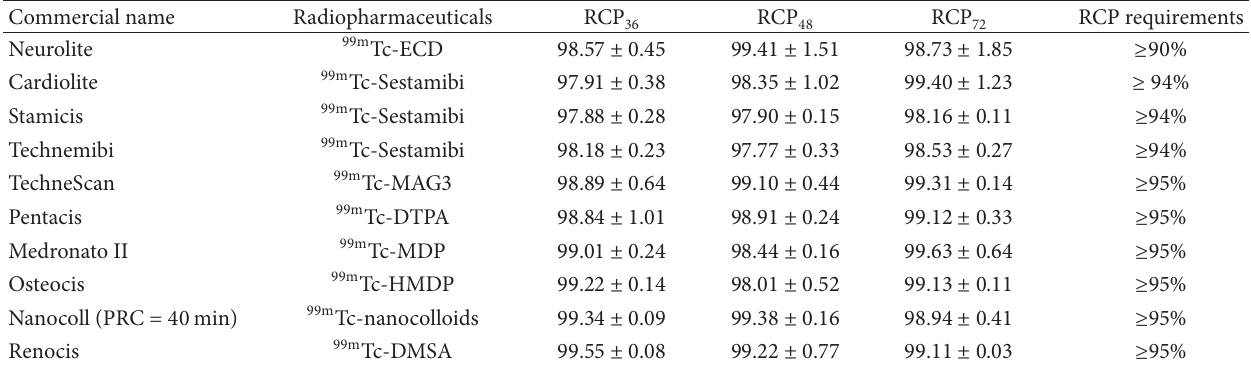
Table 3: RCP of radiopharmaceuticals at 𝑡 = 0 , prepared with generator DRYTEC GE Healthcare eluates at time superior to 24 h from the last